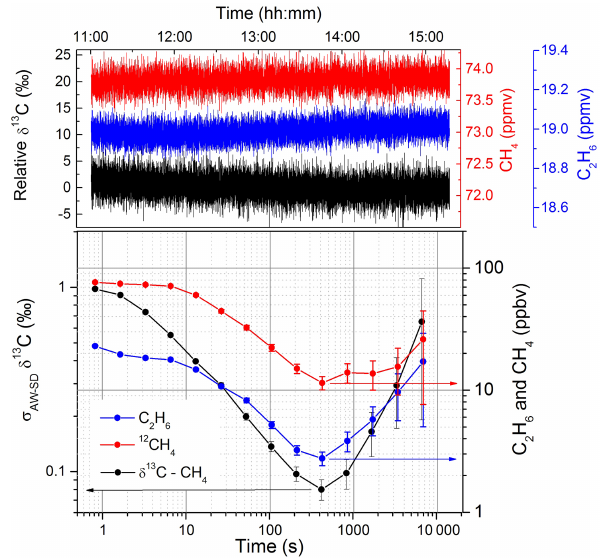
Figure 4. The Allan–Werle standard deviation for a 4h time series of measurement with 73.7ppmv of methane (black) and 19ppmv of ethane (blue) in dry air. The best integration time of the system cor- responds to ∼ 8min and the achieved precision is 0.08‰, 11ppbv, and 3ppbv for δ 13 C-CH 4 , 12 CH 4 , and C 2 H 6 , respectively.